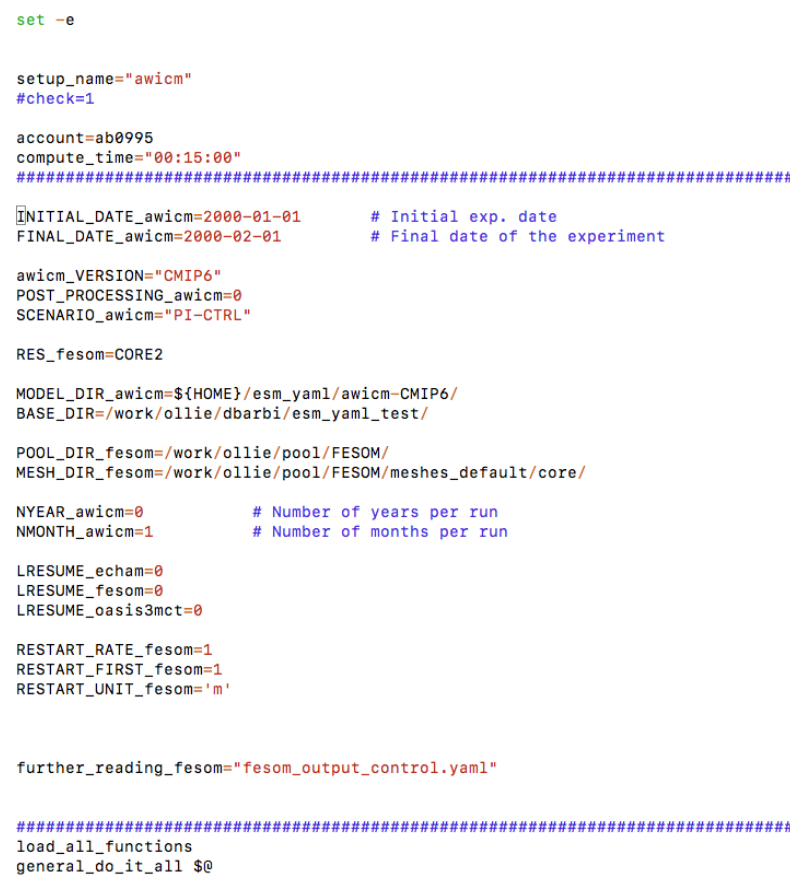
Figure A1. Example runscript, coupled model setup AWICM-2.0, shell